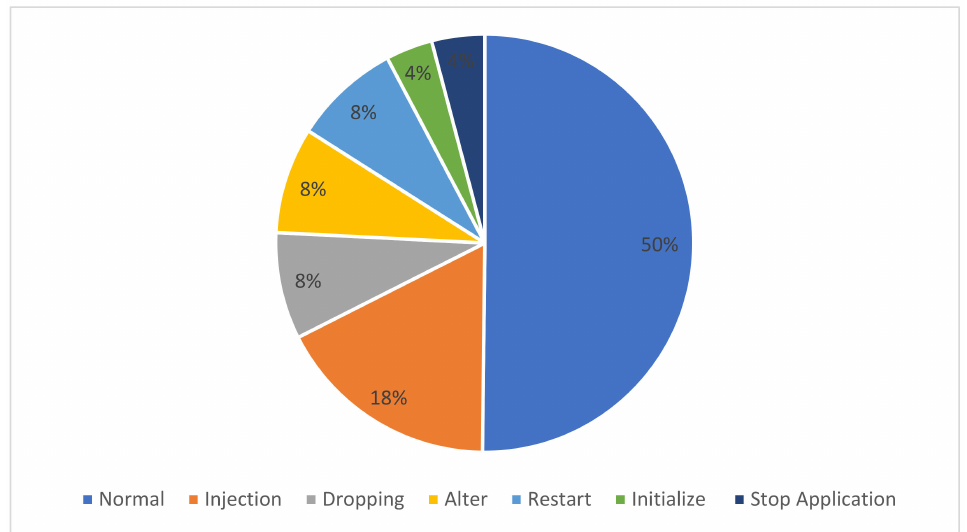
Figure 10. Function code distributions for dataset